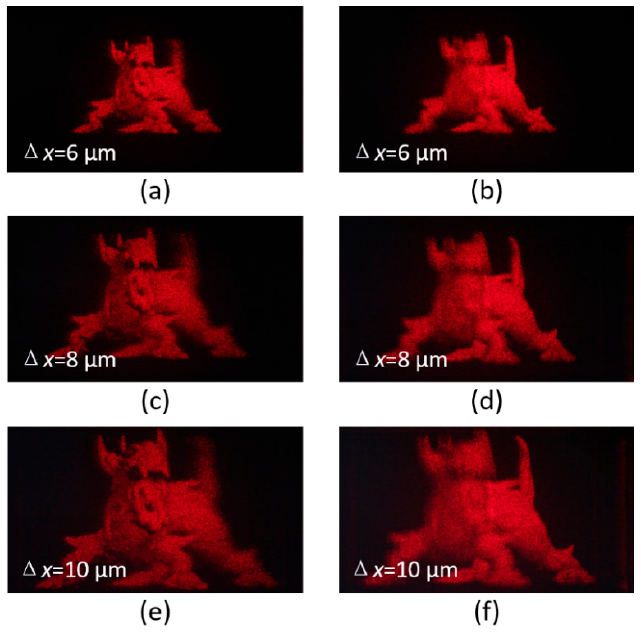
Figure 6. Optical reconstructions of CGHs at different sampling rates. ( a ), ( c ) and ( e ) focus on the head; ( b ), ( d ) and ( f ) focus on the tail.